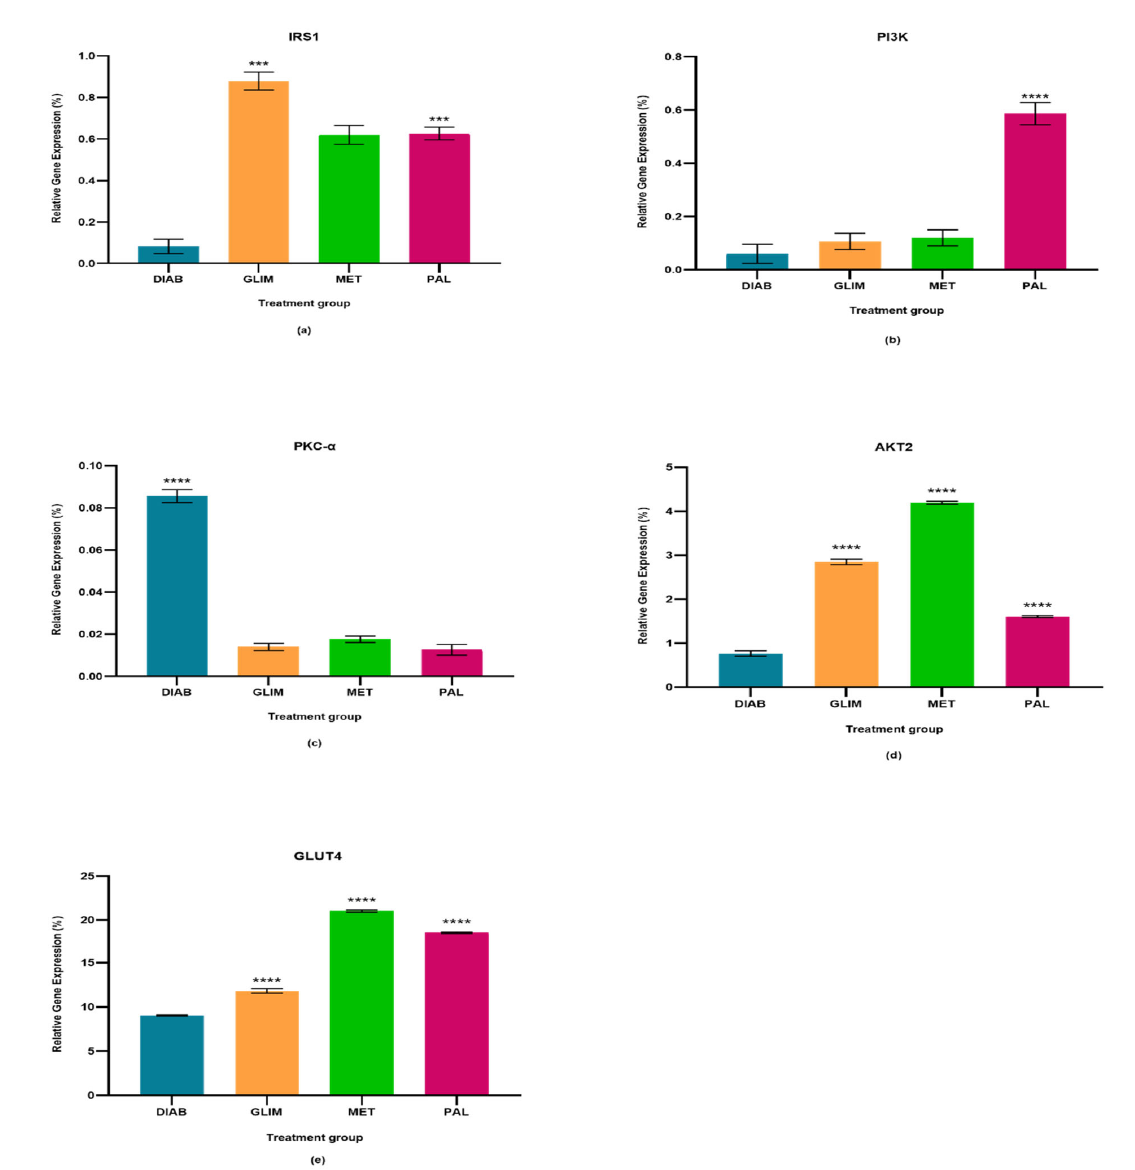
Figure 1. In the cell culture model, relative quantification of ( a ) IRS ‐ 1, ( b ) PI3K, ( c ) PKC ‐α , ( d ) AKT2, and ( e ) GLUT4 expressions in diabetic, glimepiride, metformin, and palmatine treatment groups. The gene was normalized against a geometric mean of two housekeeping genes ( β‐ actin and γ‐ actin). All the data points were presented as mean SD. Palmatine group vs. other treatment groups: *** p < 0.001, **** p < 0.0001.